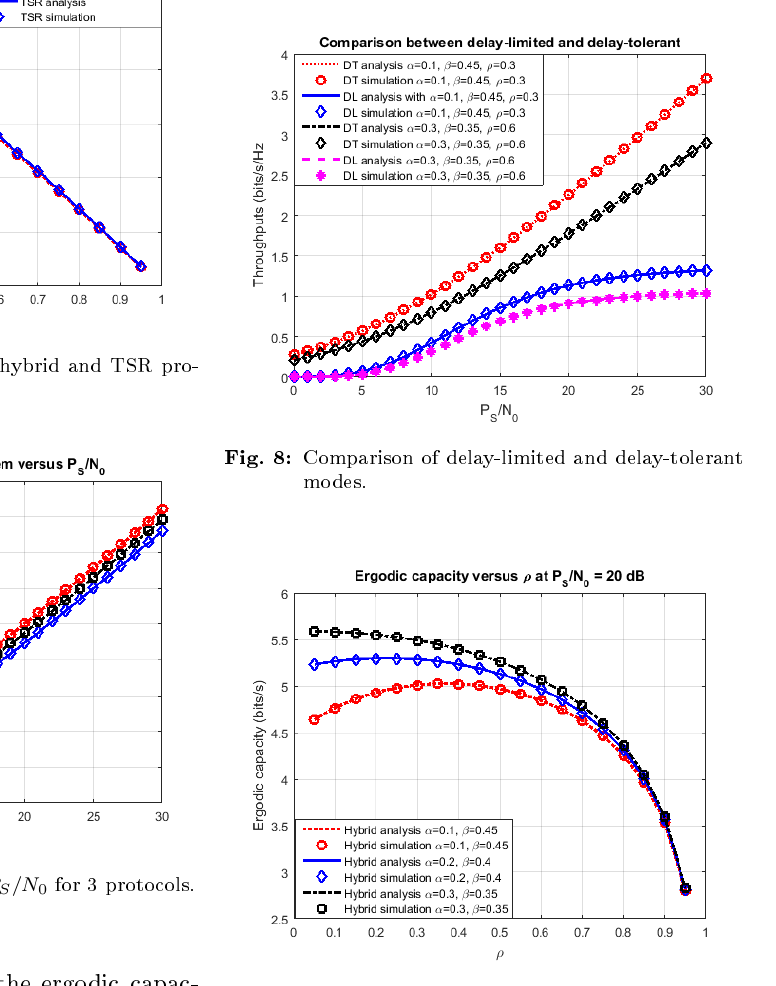
Fig. 9: Ergodic capacity of hybrid TSR-PSR versus ρ